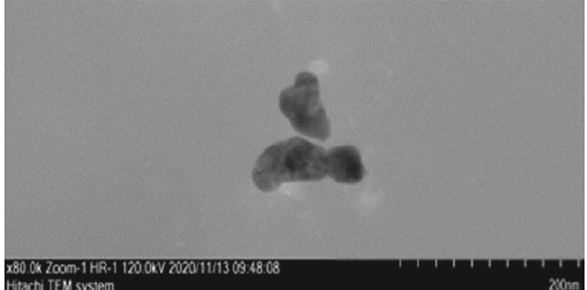
Figure 1. Transmission electron microscopy image of